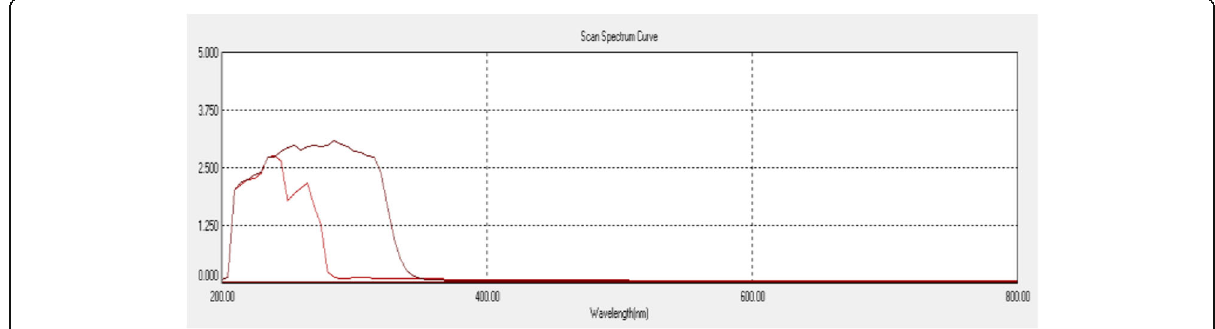
Fig. 4 UV-spectra of Tezacaftor and Ivacaftor